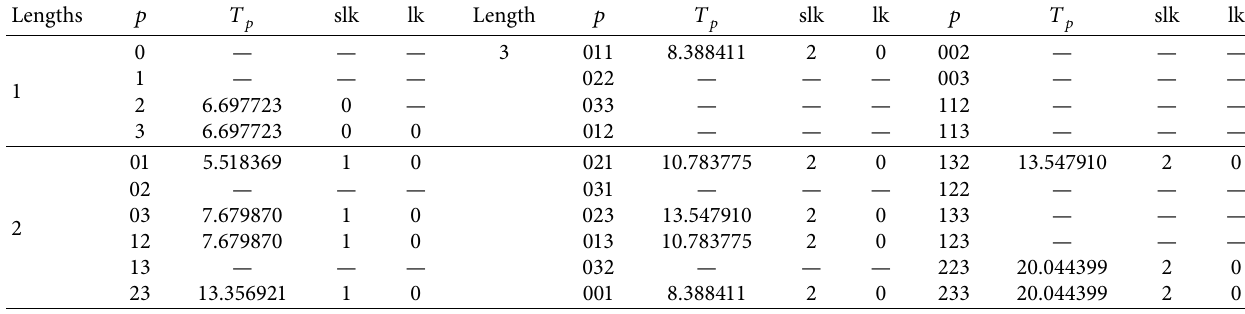
Table 2: Unstable cycles in the Rucklidge system for ( a, b ) � ( 2 , 9 . 3 ) . Listed are the topological lengths, itineraries p , periods T numbers slk, and linking numbers of other cycles and cycle 2 lk.